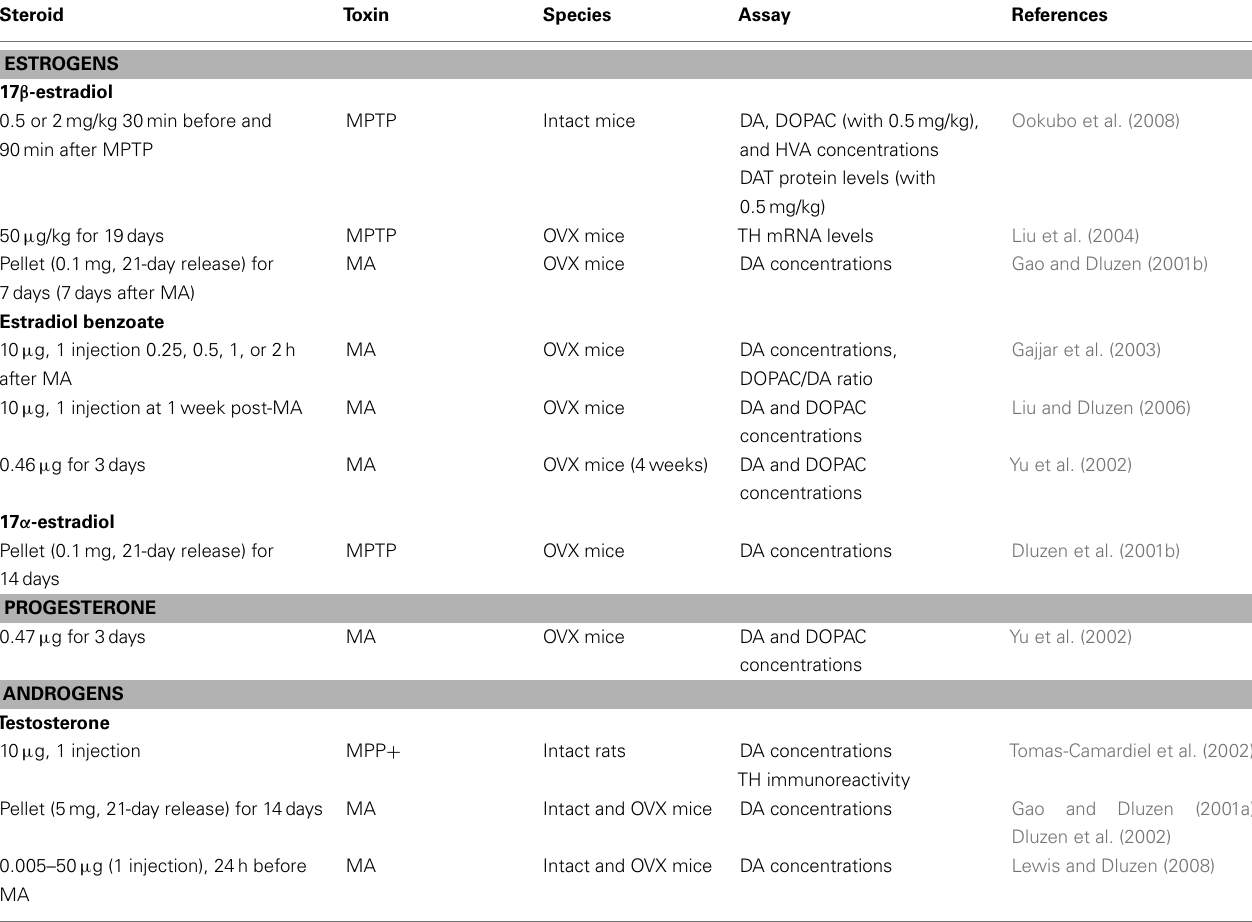
Table 2 | In vivo studies and neuroprotection in female rodents: studies showing no protection of DA markers.